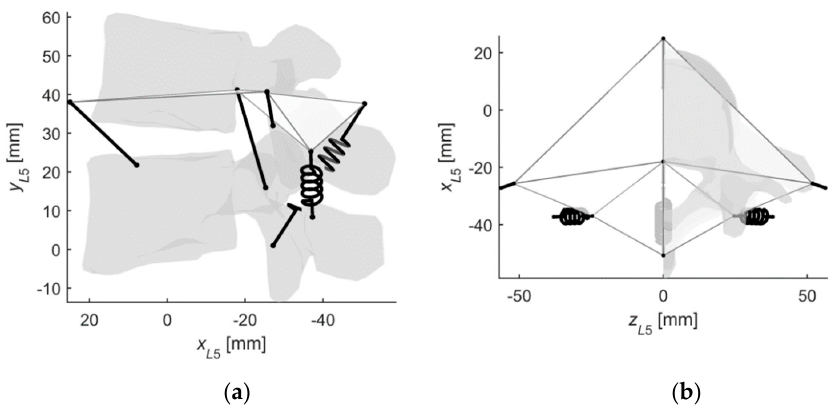
Figure 4. The substitute mechanism for the IJ (Case #1), three-dimensional view.